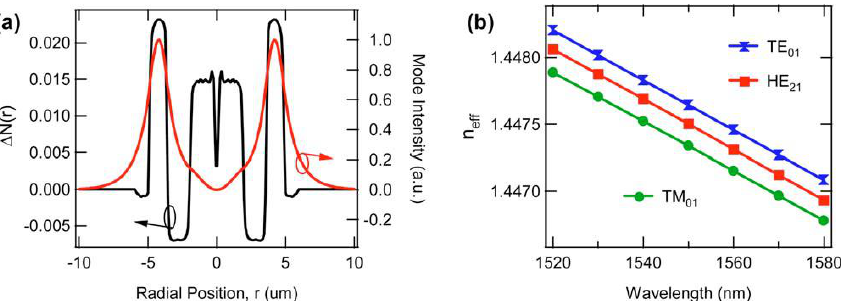
Figure 4. ( a ) Measured index profile of the fabricated fiber and simulated intensity distribution of the LP 11 mode. ( b ) Measured n eff of TE 0,1 , HE 2,1 , and TM 0,1 of the fiber shown in ( a ). Reprinted with permission from Ref. [34] © The Optical Society.